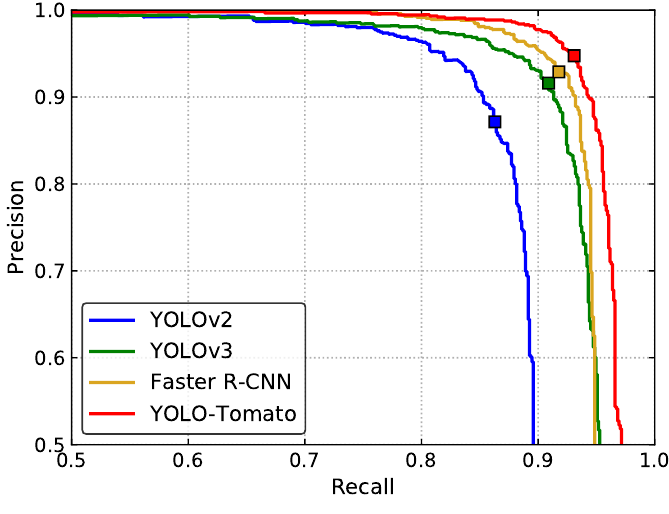
Figure 16. P–R curve for different detection methods. Table 5. A comparison of different tomato detection